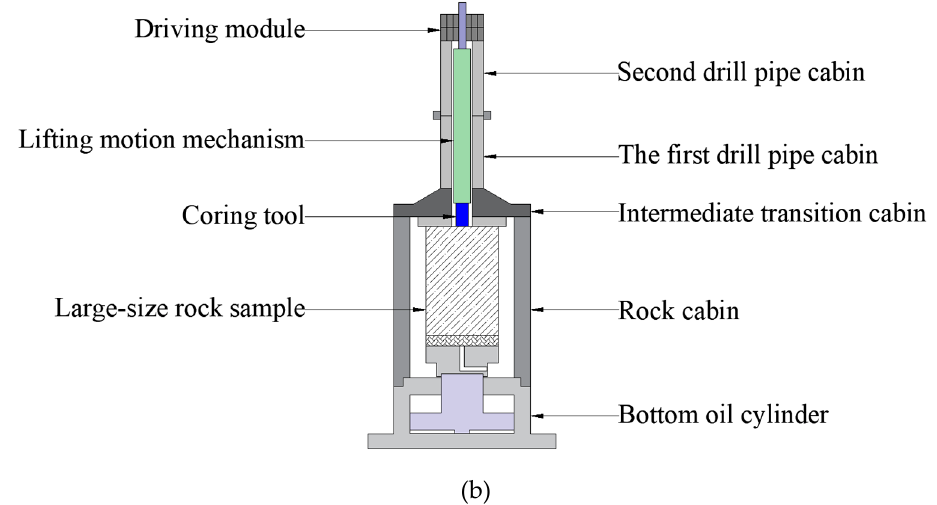
Figure 4. Overall structure of the simulation test cabin. ( a ) 3D model. ( b ) Two-dimensional cross- section.